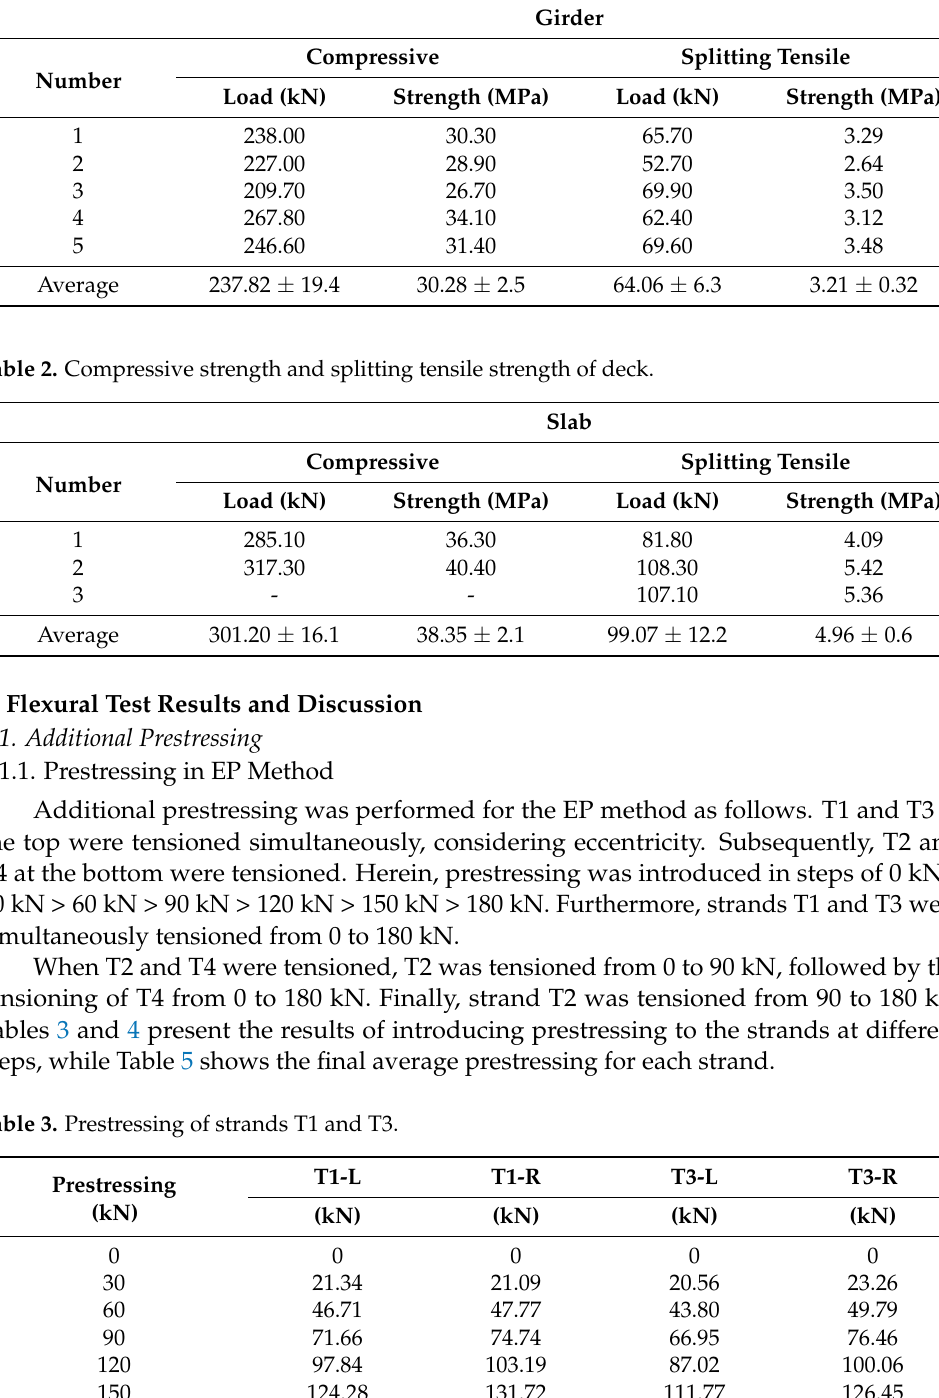
Table 1. Compressive and splitting tensile strengths of girder.